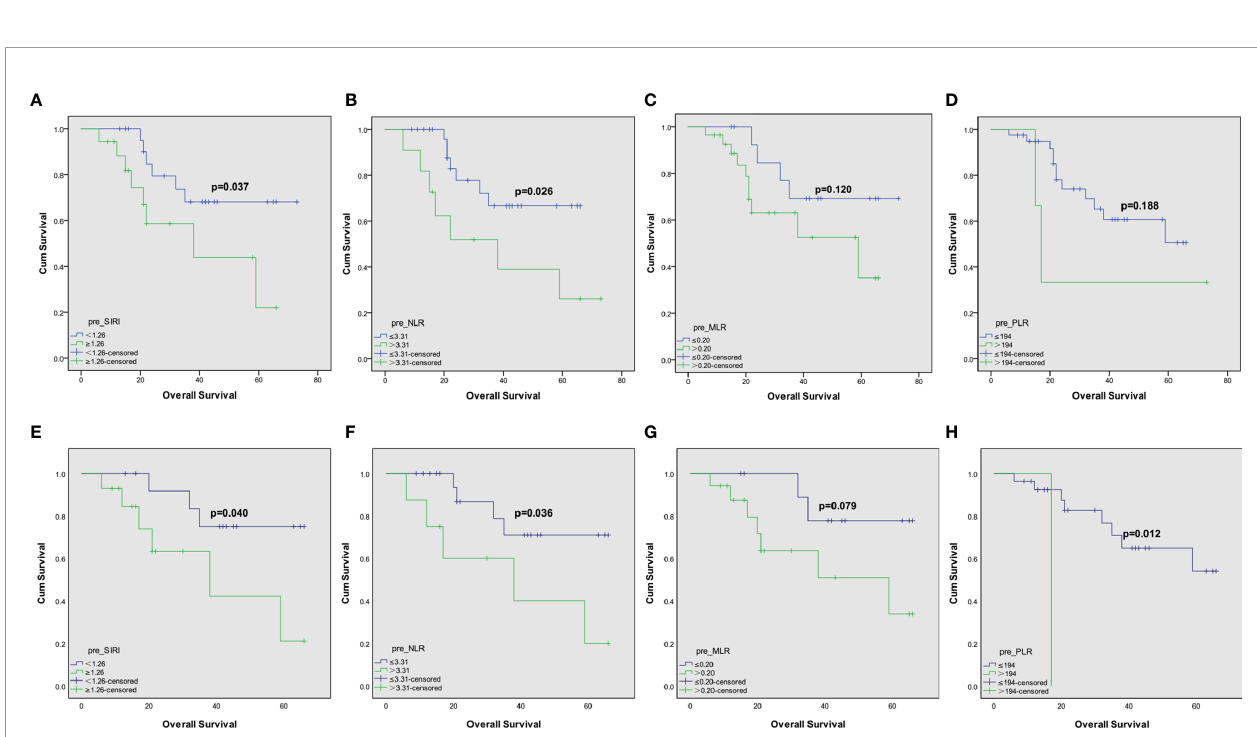
FIGURE 2 | Kaplan – Meier curves for patients strati fi ed based on (A) SIRI, (B) NLR, (C) MLR and (D) PLR in operable grade III glioma patients in complete dataset. And Kaplan – Meier curves for patients strati fi ed based on (E) SIRI, (F) NLR, (G) MLR and (H) PLR in operable grade III glioma patients after propensity